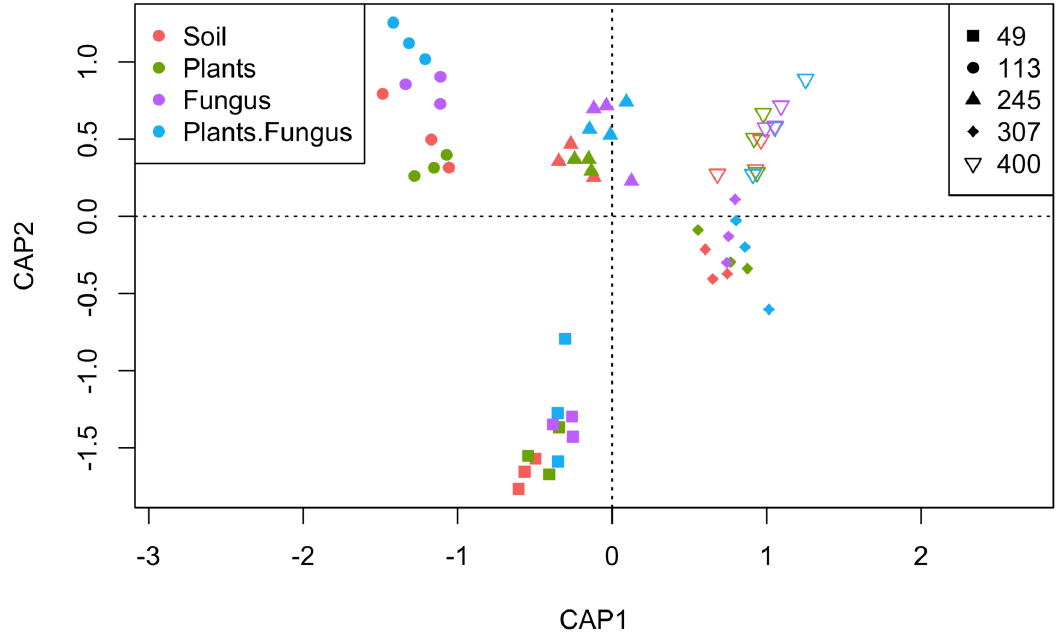
Figure 8. Unconstrained distance-based redundancy analysis (dbRDA) biplot illustrating that the water quality data clusters primarily according to sampling date (shapes) rather than by biological attribute (color). The distance between data points is proportional to their